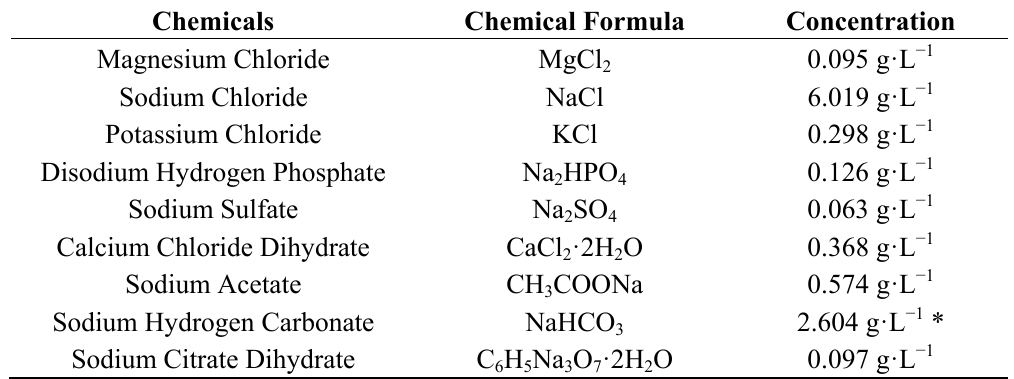
Table 2. Concentrations of chemicals used to prepare Gamble’s solution [38].